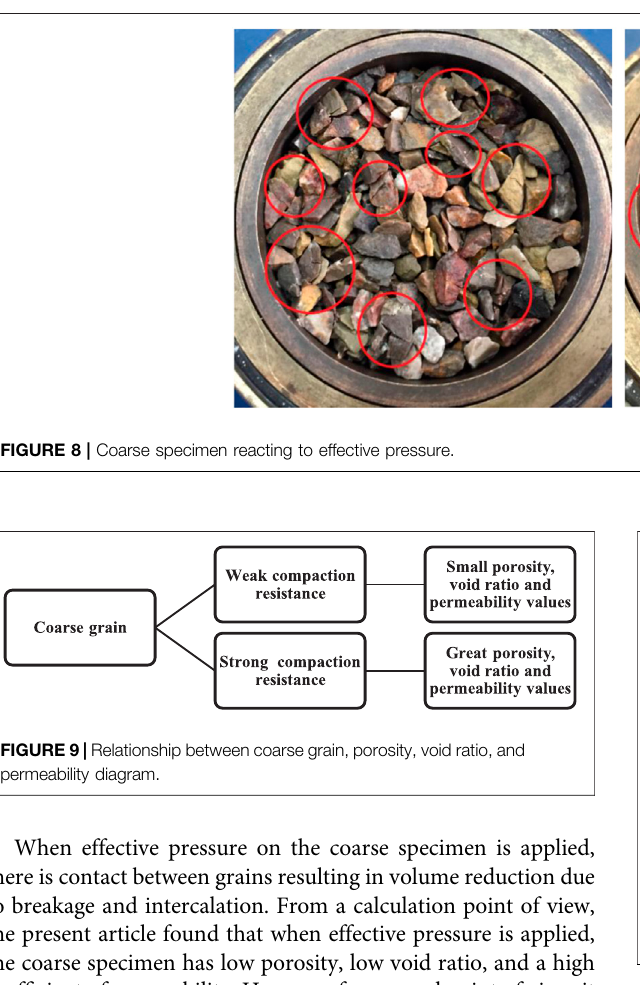
4:1:2 specimens, specimens that contain an amount of coarse agrees with Rahmouni et al. (2014) that permeability and porosity